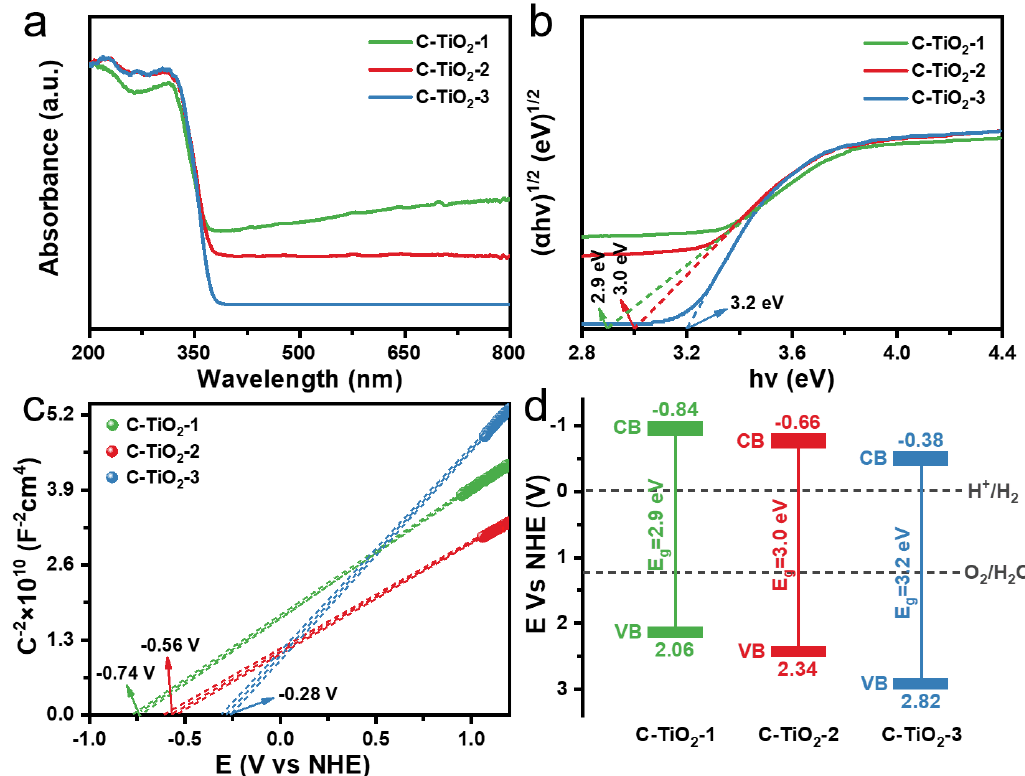
Figure 5. ( a , b ) Diffuse reflectance spectrum of the prepared C − TiO 2 − 1, C − TiO 2 − 2 and C − TiO 2 − 3 photocatalysts and Tauc plots. ( c ) Mott – Schottky plots and ( d ) E l ectronic band diagram of the C − TiO 2 − 1, C − TiO 2 − 2 and C − TiO 2 − 3.